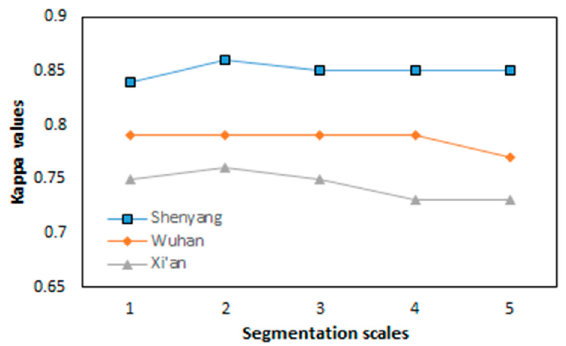
Figure 16. Relationships between segmentation scales and Kappa values.